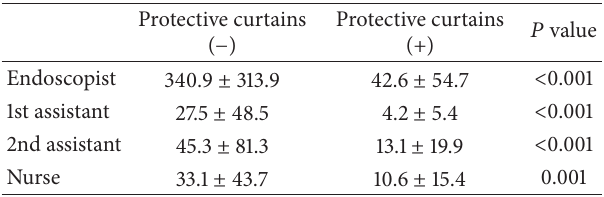
Table 2: Occupational radiation dose to medical staff members